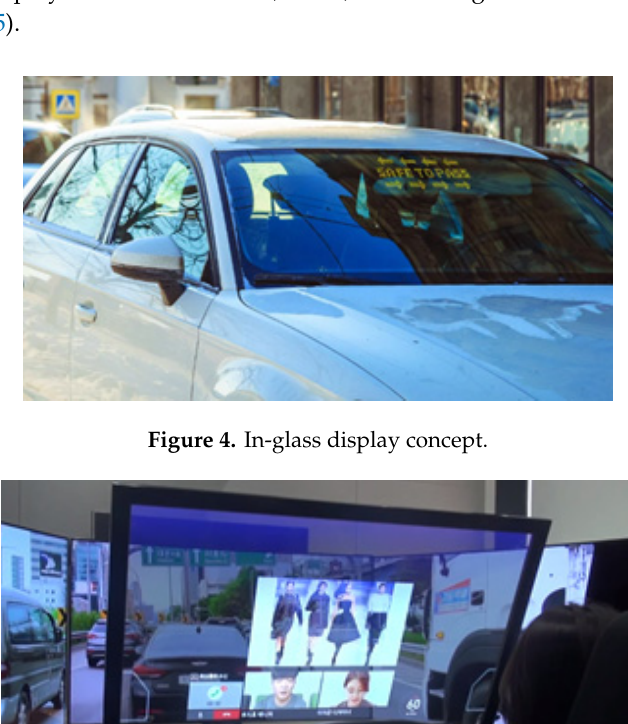
Figure 5. Smart windshield concept.